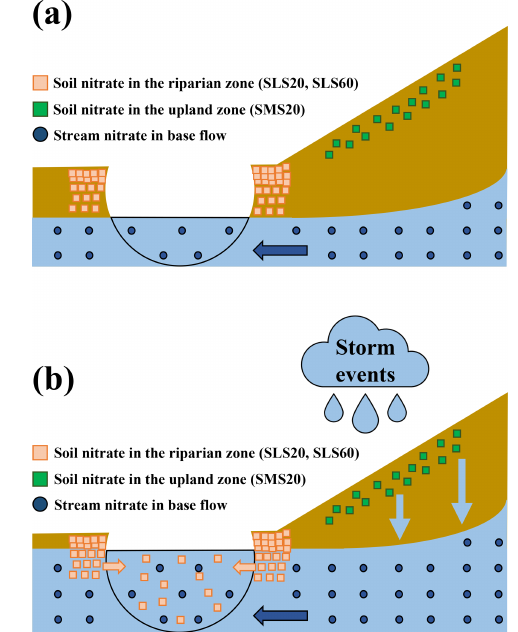
Figure 6. The elution of soil nitrate to the stream before the storm events (a) and during the storm events (b) . Soil nitrate in the ripar- ian zone and that in the upland zone are represented by the orange squares and green squares, respectively, while stream nitrate during base flow is represented by the blue